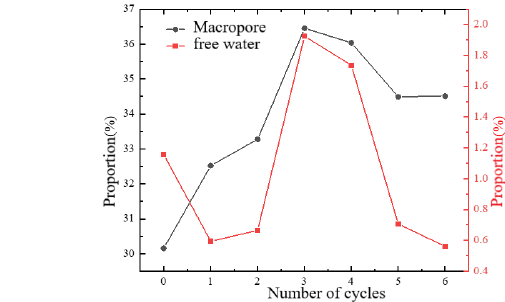
Figure 5. Evolution of the proportion of micro-, fine, and large pores, as well as free water, before and after freeze–thaw cycles .